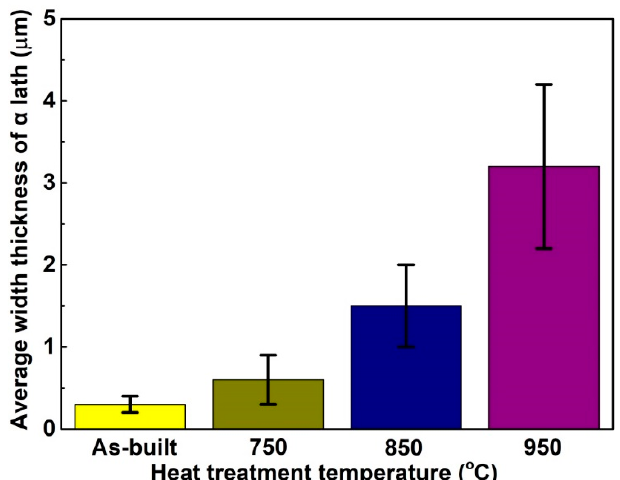
Figure 6. Average width of the α lath of porous Ti64 after different heat treatments.